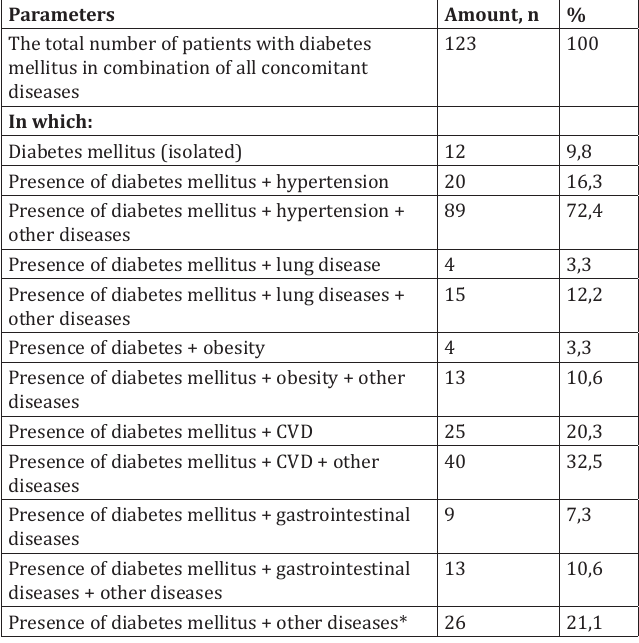
The structure of comorbidities in patients of diabetes mellitus having COVID-19